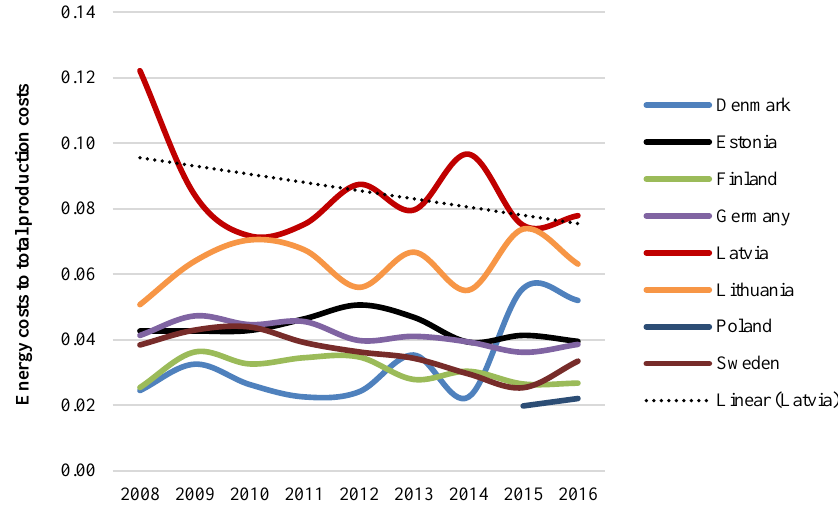
Fig. 3 . Energy costs to total production costs in sawmilling and planning of wood (NACE 1610) (Latvia and Baltic Sea region countries).